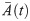
Population dynamics captures adaptation and burstiness.(A) 500 adapting leaky integrate-and-fire neurons were stimulated by a step current Iext that increased μ = urest + RIext(t) from μ = 12 mV to μ = 27 mV (top). Voltage trace of one neuron (bottom). Stationary firing statistics (rate and coefficient of variation (CV)) corresponding to the two stimuli are indicated above the step current. (B) Realizations of the population activity obtained from microscopic simulation (black) and mesoscopic population equation (blue) as well as A¯(t) (magenta). (C) Power spectra corresponding to the stationary activity (averaged over 1024 trials each of 20 s length) at low and high firing rates as in (A), circles and lines depict microscopic and mesoscopic case, respectively. Parameters in (A)–(C): uth = 10 mV, ur = 25 mV, threshold kernel θ(t)=∑ℓ=1,2(Jθ,ℓ/τθ,ℓ)e-t/τθ,ℓ for t ≥ tref with Jθ,1 = 1.5 mV⋅s, τθ,1 = 0.01 s, Jθ,2 = 1.5 mV⋅s, τθ,2 = 1 s. (D) Bursty neuron model. (i) Biphasic threshold kernel θ(t), where a combination of a negative part (facilitation) and a positive part (adaptation) yields a bursty spike pattern, (ii) sample firing pattern of one neuron. (iii) The interspike interval distribution with values of rate and CV. (E) Power spectrum of the population activity AN(t) shown in (D)-(iv). Parameters in (D) and (E): μ = 20, uth = 10 mV, ur = 0 mV, τm = 0.01 s, facilitation: Jθ,1 = −0.45 mV⋅s, τθ,1 = 0.05 s; adaptation: Jθ,2 = 2.5 mV⋅s, τθ,2 = 1 s.